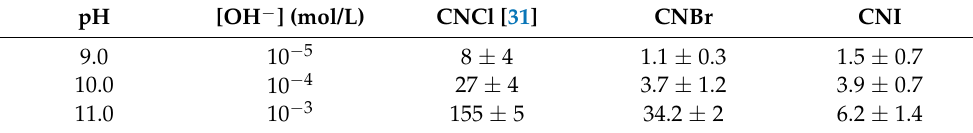
Table 2. Reaction rate constants of CNXs compounds at different pH values ( k h , 10 −5 s −1 ).